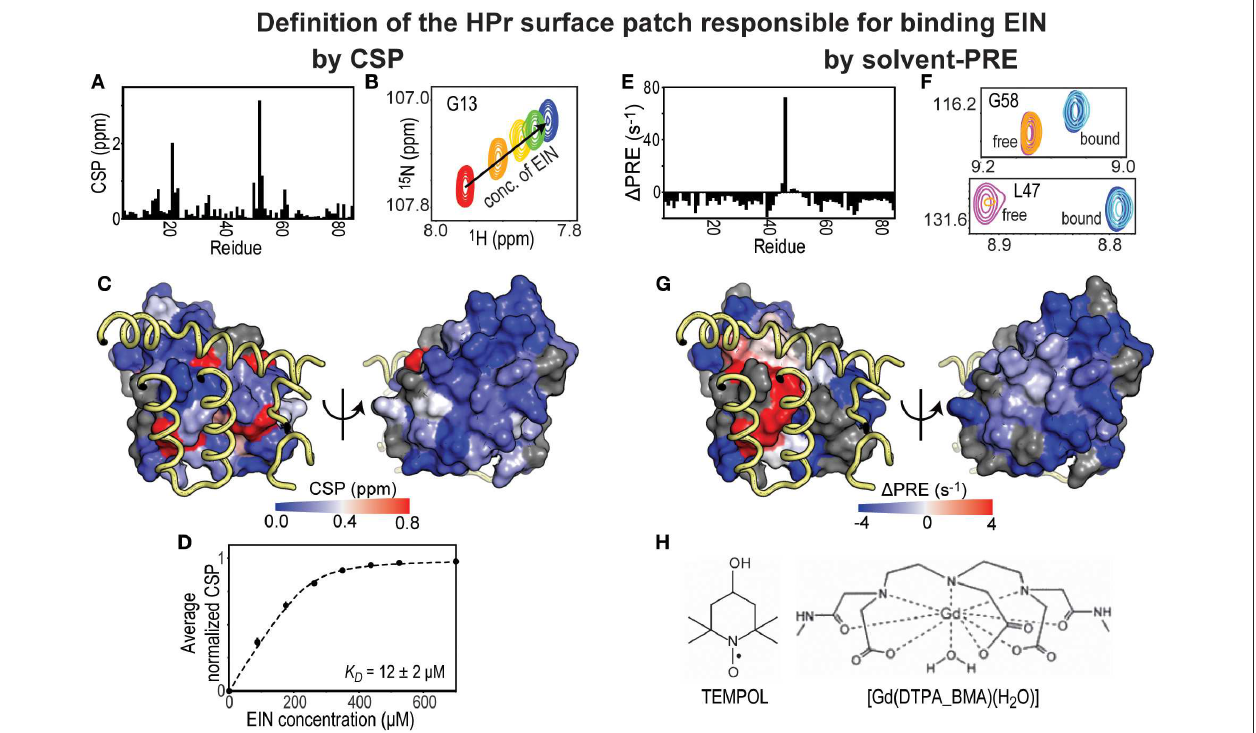
FIGURE 1 | Solvent-PRE and CSP analysis of EIN-HPr complex. (A) CSP measured for 15 N-labeled HPr in the presence of saturating concentrations of unlabeled EIN are plotted vs. residue index. (B) Example cross-peak from 1 H- 15 N HSQC spectrum of 15 N-labeled HPr measured at increasing concentration of EIN. A peak from the complex interface was selected. (C) The CSP data from panel (A) are plotted on the surface of HPr according to the color bar. The relevant portions of EIN are shown as yellow tubes. (D) CSP vs. concertation of EIN (black circles). The data can be fit (black line) to return the K D of the EIN-HPr complex. (E) 1 PRE vs. residue index. 1 PREs are calculated by subtracting the solvent-PREs (i.e., the increase in 1 H N - R 2 caused by addition of 4mM Gd(DTPA-BMA) to the NMR sample) measured for 15 N-labeled HPr complexed to unlabeled EIN from the solvent-PRE data measured for the free protein. While the majority of the HPr residues show a negative 1 PRE (which is the result of the reduced rotational diffusion of complexed HPr compared to the free protein), obstruction of the paramagnetic probe from the binding interface results in positive 1 PREs. (F) Example cross-peaks from 1 H- 15 N HSQC spectra of 0.8mM 15 N-labeled HPr in the presence of 0mM EIN and 0mM Gd(DTPA-BMA) (pink), 0mM EIN and 4mM Gd(DTPA-BMA) (orange), 1mM EIN and 0mM Gd(DTPA-BMA) (blue), 1mM EIN and 4mM Gd(DTPA-BMA) (cyan). The two cross-peaks have been chosen to illustrate the cases of a residue located far from the complex interface (G58) and of an HPr residue that is in direct contact with EIN (L47). (G) 1 PREs are plotted on the surface of HPr according to the color bar. The relevant portions of EIN are shown as yellow tubes. (H) Structures of two commonly used paramagnetic probes for surface accessibility